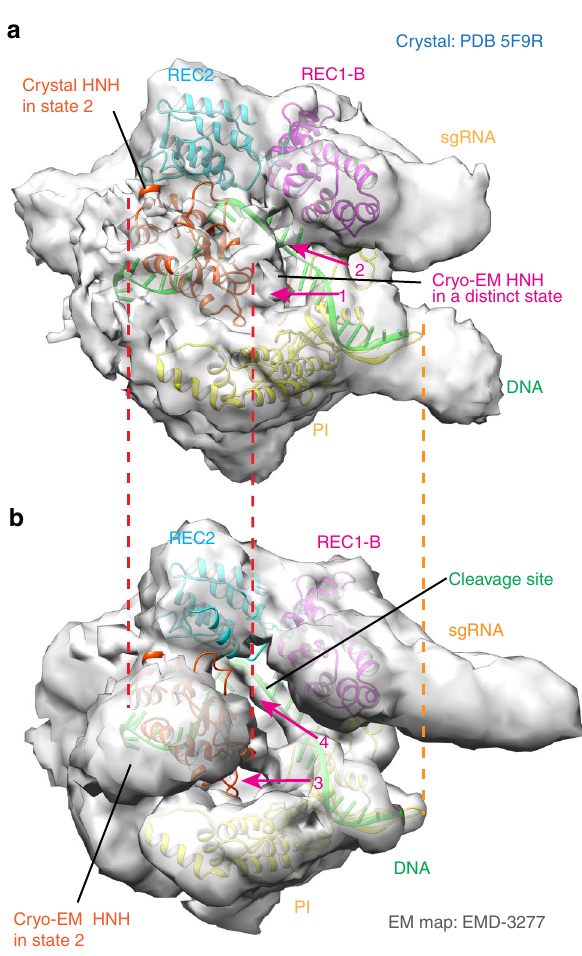
Fig. 2 The conformational state 3 of the HNH domain revealed by the cryo- EM density map. a Density regions that indicate a closer contact of the HNH domain with the REC1 and PI domains (contoured at ~1.0 σ ), as indicated by arrows 1 and 2. The dashed lines indicate the boundaries of the HNH and PI domains in the fi tted crystal structure (PDB 5F9R). b No corresponding regions in the EM density map of the ternary complex with a 40-bp target DNA (contoured at ~1.7 σ ), as indicated by arrows 3 and